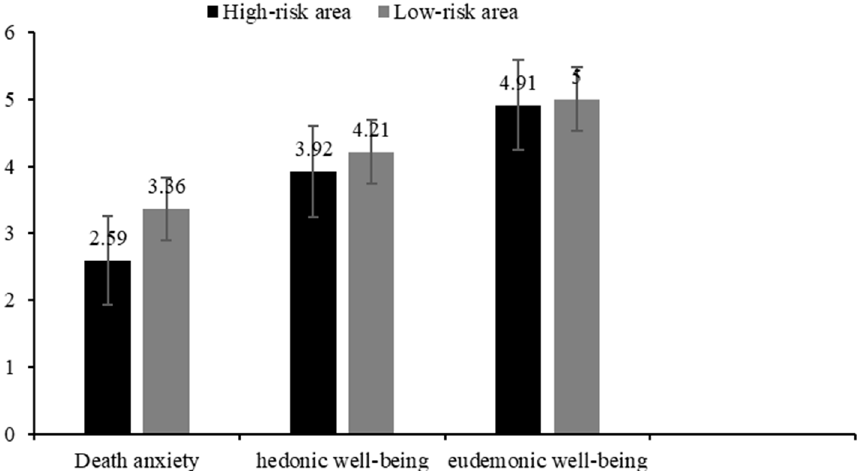
Figure 1. Descriptive Results of Different Variables in Different Locations.